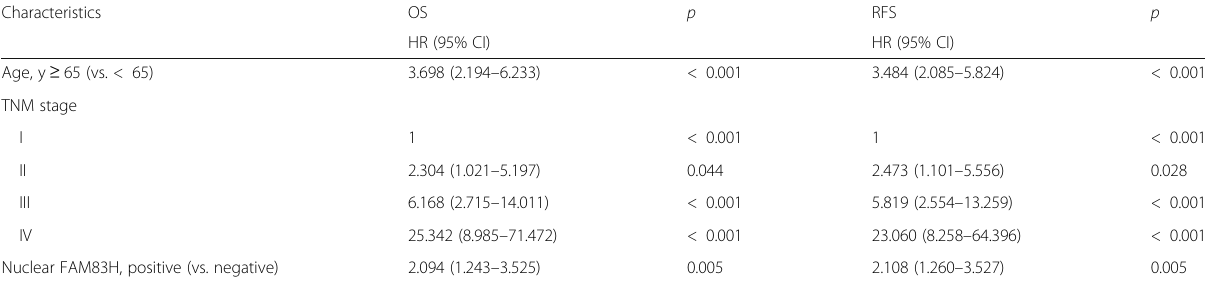
Table 3 Multivariate Cox regression analysis for overall survival and relapse-free survival Characteristics